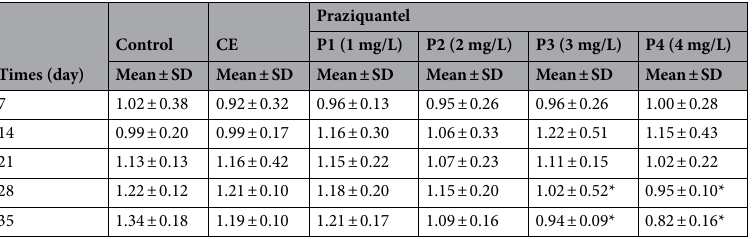
Table 1. Mean Fulton’s condition factor for common carp during exposure to praziquantel. *Experimental groups significantly ( p < 0.01) different from the control group. SD = standard deviation. Groups: CE (solvent control, contained 0.8 ml/L ethanol), P1 (praziquantel 1.0 mg/L), P2 (praziquantel 2.0 mg/L), P3 (praziquantel 3.0 mg/L) and P4 (praziquantel 4.0 mg/L).